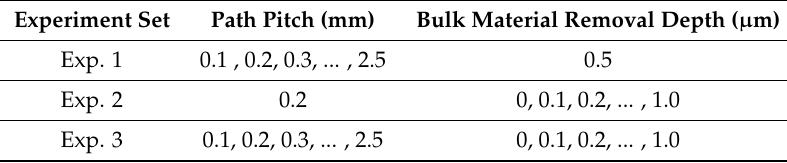
Table 2. Simulation experiment